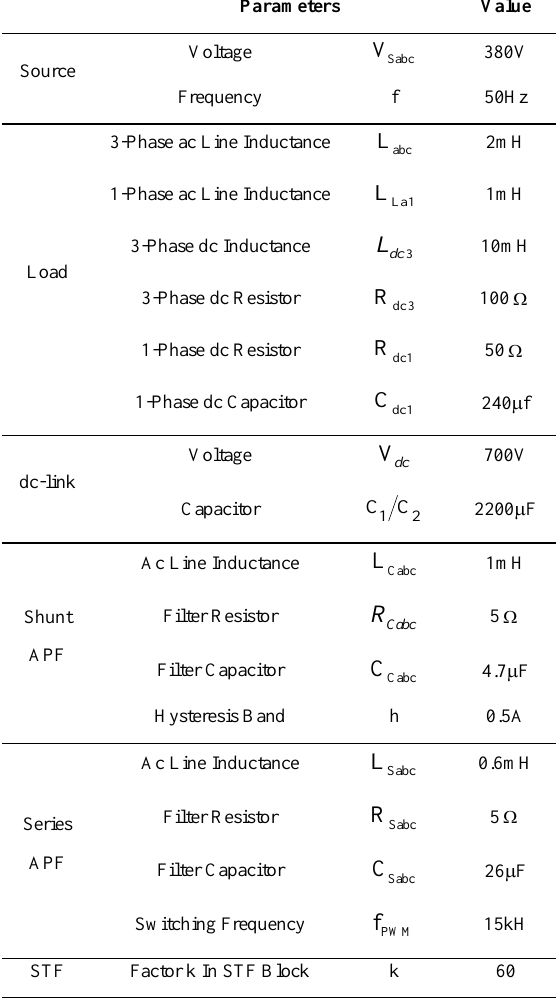
Table 1. System parameters [19].